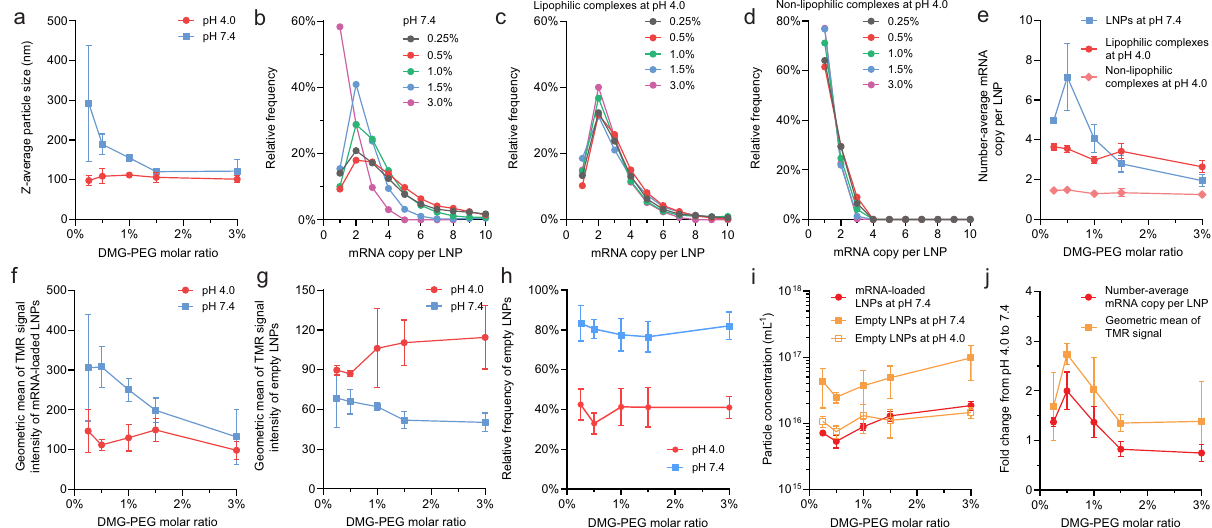
Fig. 3 | Effects of molar ratio of DMG-PEG on the payload capacity and lipid content of mRNA LNPs (DLin-MC3-DMA: DSPC: cholesterol: DMG-PEG= 50:10:40-x:x). a The z-average particle diameter of mRNA LNPs assessed by dynamic light scattering (DLS). b – d The mRNA payload distribution pro fi les of formulations at b pH 7.4; c pH 4.0 for lipophilic complexes; or d pH 4.0 for non- lipophilic complexes. e The number-average mRNA copy per LNP. f , g The geo- metricmeanofTMRsignals(indicatorofrelativehelperlipidcontent)of f lipophilic complexes at pH 4.0 and mRNA-loaded LNPs at pH 7.4; or g empty LNPs at either